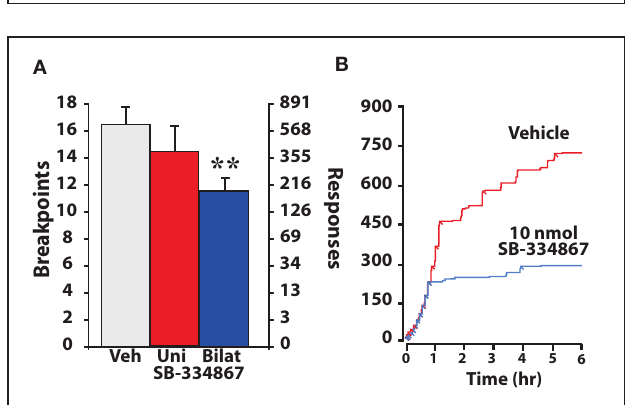
FIGURE 5 | Hypocretin infusions into the VTA increase the motivation to take cocaine on a PR schedule of reinforcement. (A) Shown are the mean ± SEM number of cocaine breakpoints and lever responses following unilateral or bilateral intra-VTA infusions of vehicle (uni, n = 5; bilat, n = 6) or 0.5nmol hypocretin-1 (HCRT-1; uni, n = 5; bilat, n = 6). (B) Shown are event records from an individual rat that received a bilateral intra-VTA infusion of vehicle or 0.5nmol hypocretin-1. Cocaine injections are indicated by diagonal tick marks. Relative to vehicle, hypocretin-1 increases the motivation to take cocaine as evidenced by increased breakpoints and lever responding. ∗ P < 0 . 05 relative to vehicle. Modified from España et al. (2011).